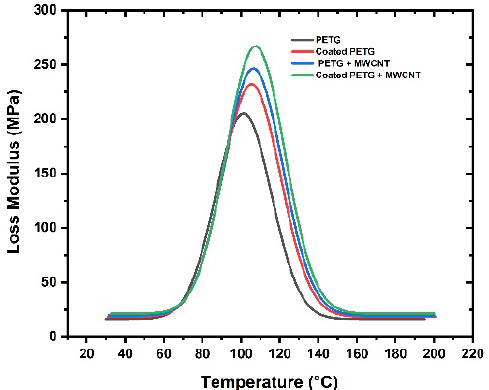
Figure 10. Loss modulus vs. temperature.